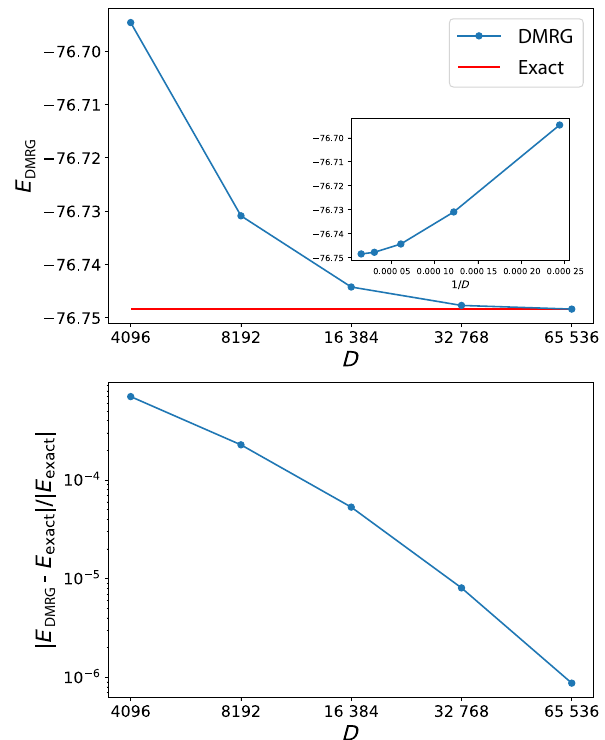
FIG. 2. Top: convergence of the DMRG ground-state energy towards the exact value as a function of bond dimension D for a 2D system of spinless free fermions on a 10 × 10 square lattice. Bottom: convergence of the relative error in energy for the same